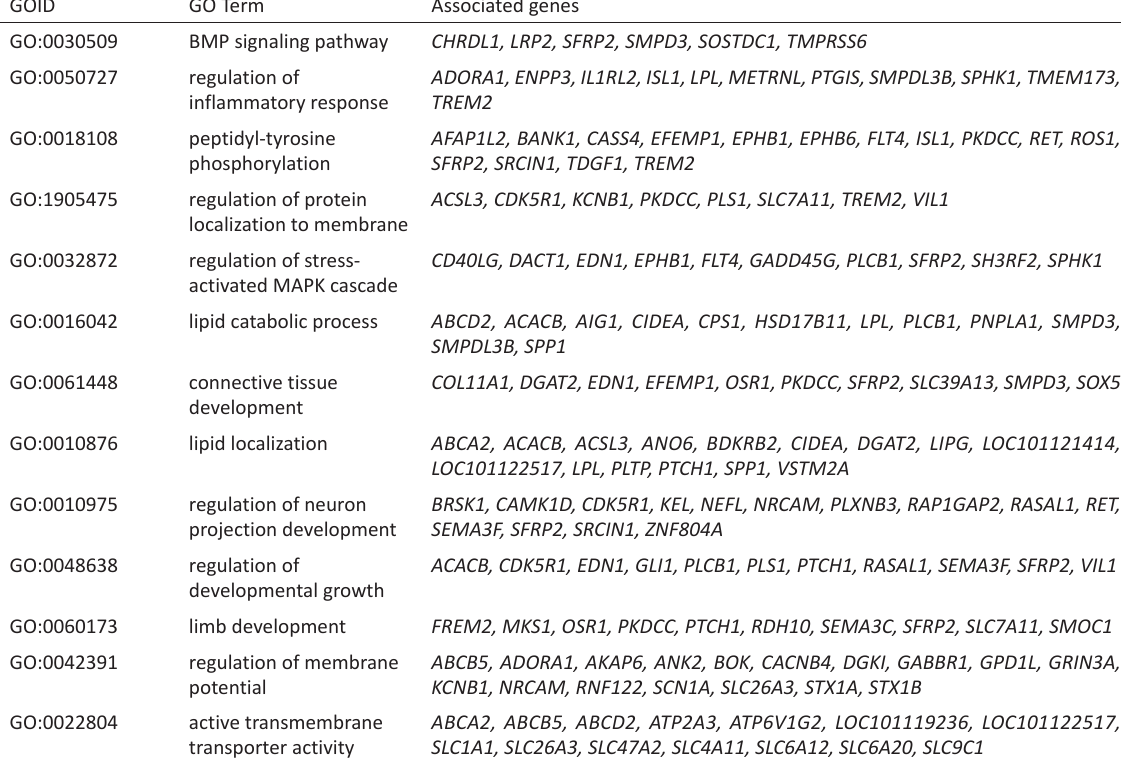
Table 5. Selected GO terms associated with the genes that were upregulated in the endometrium having spherical (S) conceptus (for more details and complete list, see Table